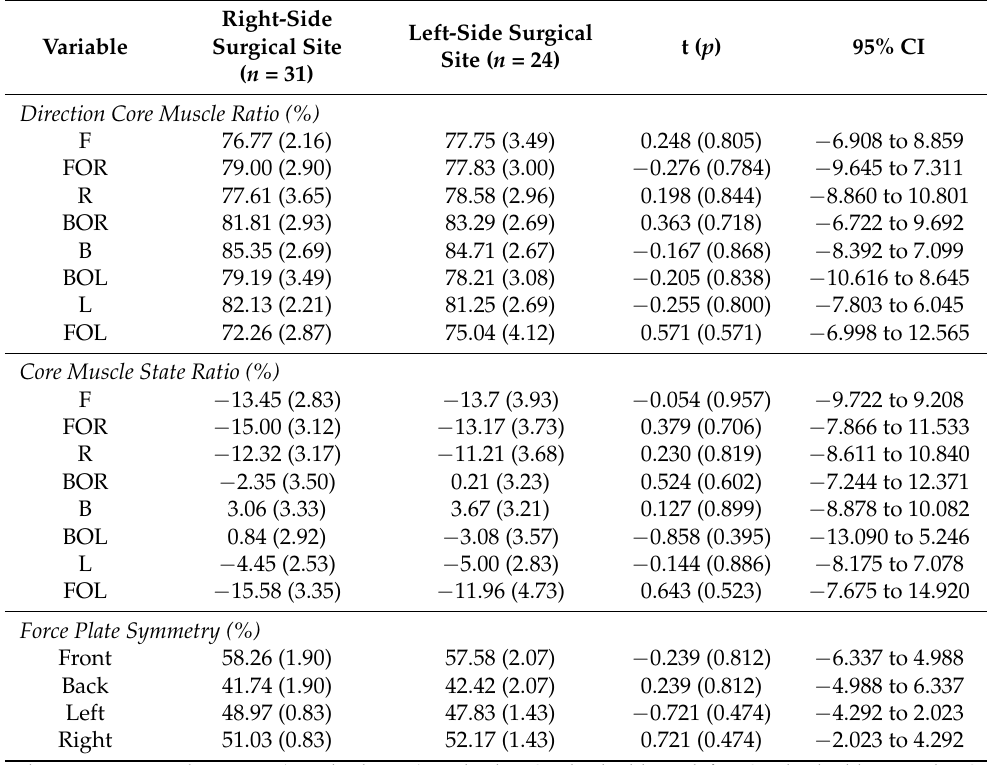
Values are presented as mean (standard error). B: back, BOL: back oblique left, BOR: back oblique right, CI: confidence interval, F: front, FOL: front oblique left, FOR: front oblique right, L: left, and R: